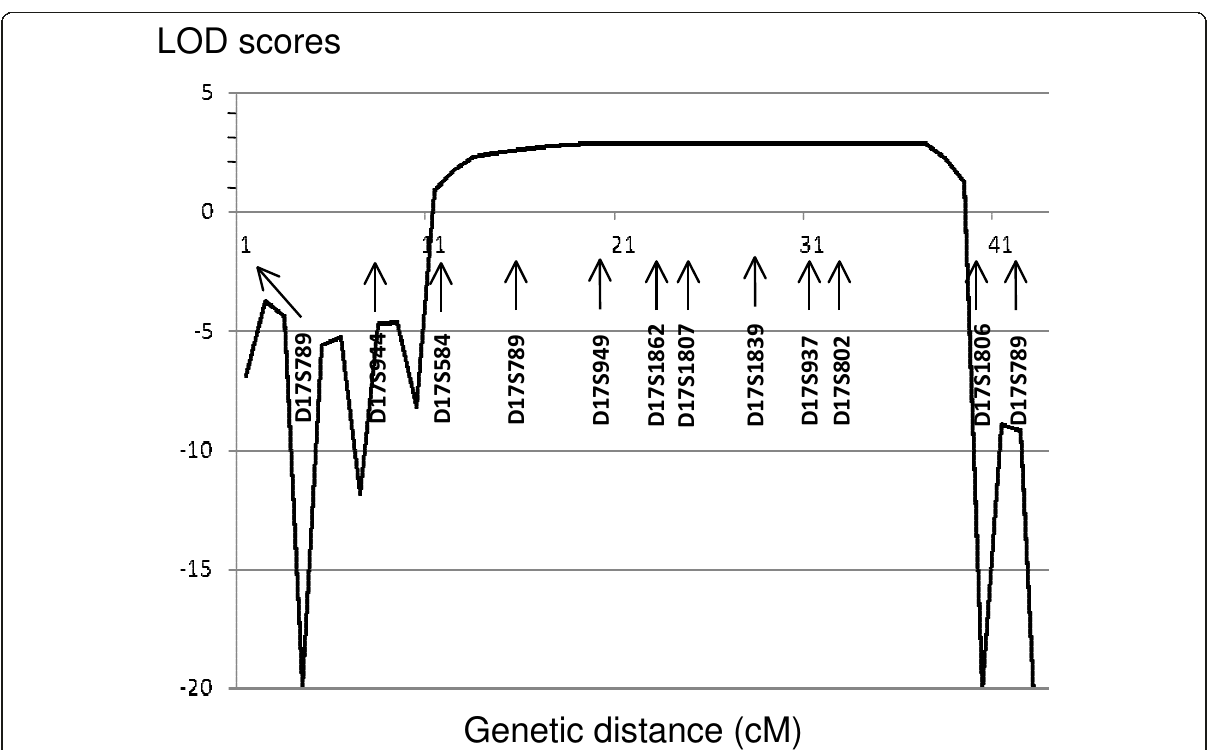
Figure 3 Multipoint linkage analysis in family RBT-DAK . The genetic distances (in cM) are represented as on the ensembl.org chromosome 17